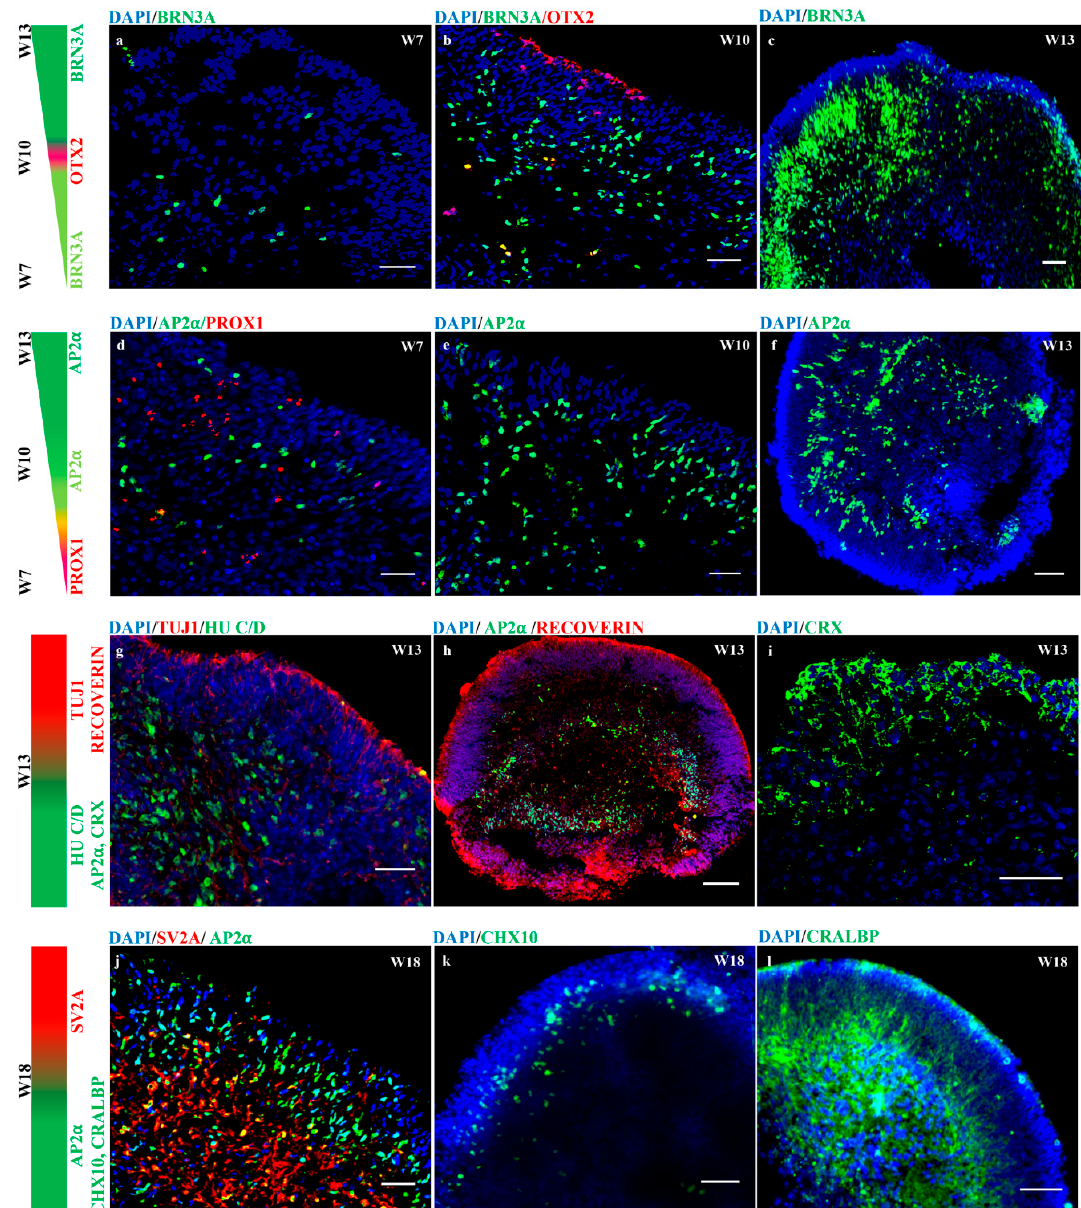
Figure 6. hiPSC-derived 3-D retinal organoids recapitulate retinal neurogenesis. Retinal progenitor cells (RPC) within 3-D retinal organoids differentiated into specific retinal neurons and organized themselves in the proper layers at specific timepoints; retinal BRN3A -positive retinal ganglion cells, ( a – c ), AP2 α -positive amacrine cells ( d – f , h , j ), precursors for major neuronal cells (ganglion and amacrine cells) positive for HU C/D ( g ), OTX2- , RECOVERIN- , & CRX -positive photoreceptor precursor cells ( b , h , i ), PROX1 -positive horizontal cells ( d ), CHX10 -positive bipolar cells ( k ), TUJ1 -positive nerve fiber layer ( g ), SV2A -positive outer plexiform layer ( j ) and CRALBP -positive Müller cells ( l ). The colors indicate for representative makers and intensities at different timepoints. Scale bars, 50 µ m ( d , i ); 100 µ m ( b , c , f – h , j – l ); 200 µ m ( a , e ).